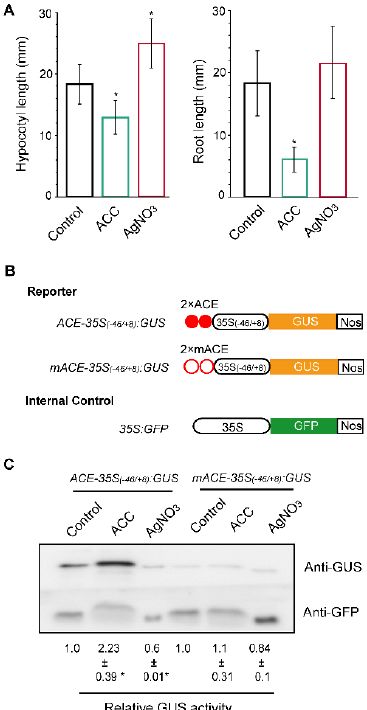
Figure 1. GUS transient assays for ACE as an ERE in the etiolated Arabidopsis seedlings. ( A ) The Arabidopsis seeds were grown in 1/2 glutathione S-transferase (MS) without (control) and with 10 μM ACC (ACC) or 50 μM AgNO 3 (AgNO 3 ) in the dark for two weeks and then subjected to hypocotyl or